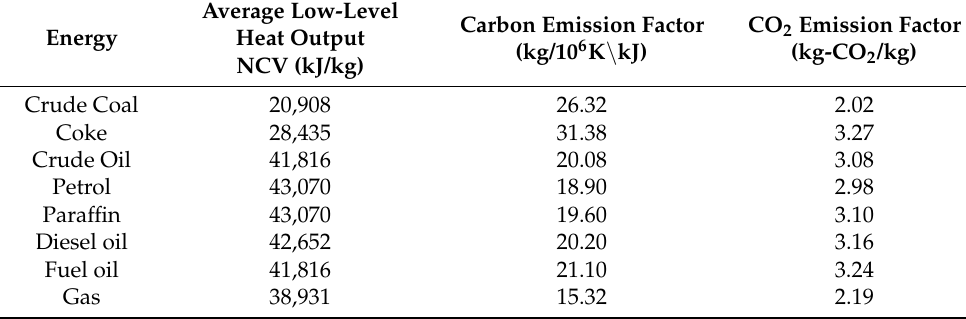
Table A1. CO 2 emission factors for various energy